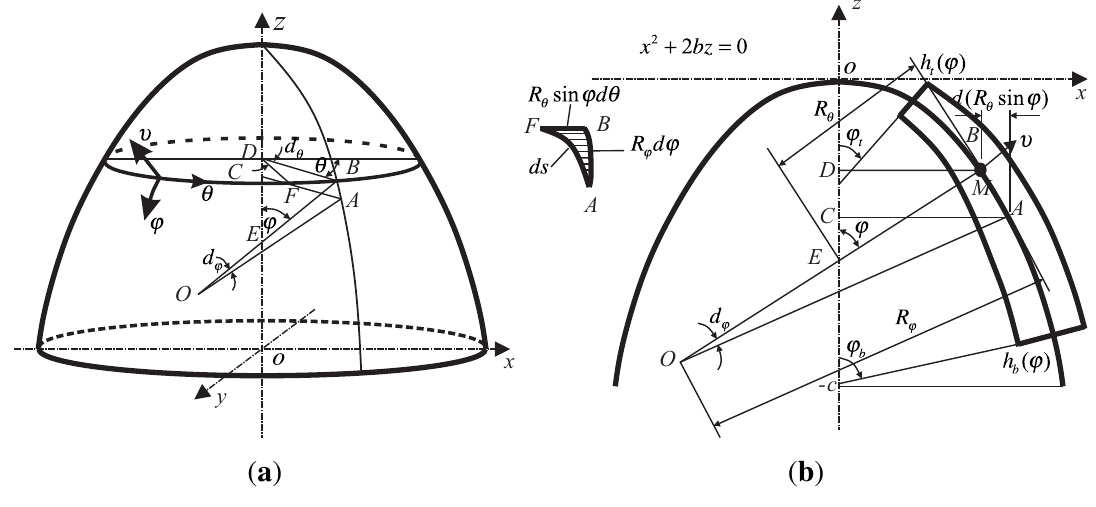
Figure 8. Schematic of the working principle. ( a ) Orthogonal Curvilinear Coordinate System. ( b ) Cross-Section